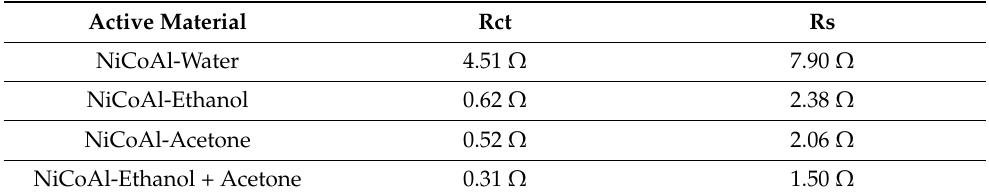
Table 7. Values of Rct and